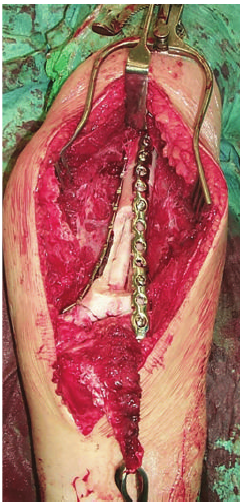
Figure 5: The construct was held in place with 2 plates running up each side of the humerus.